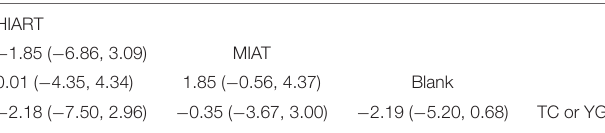
TABLE 4 | The League Table of the interventions for the superoxide dismutase